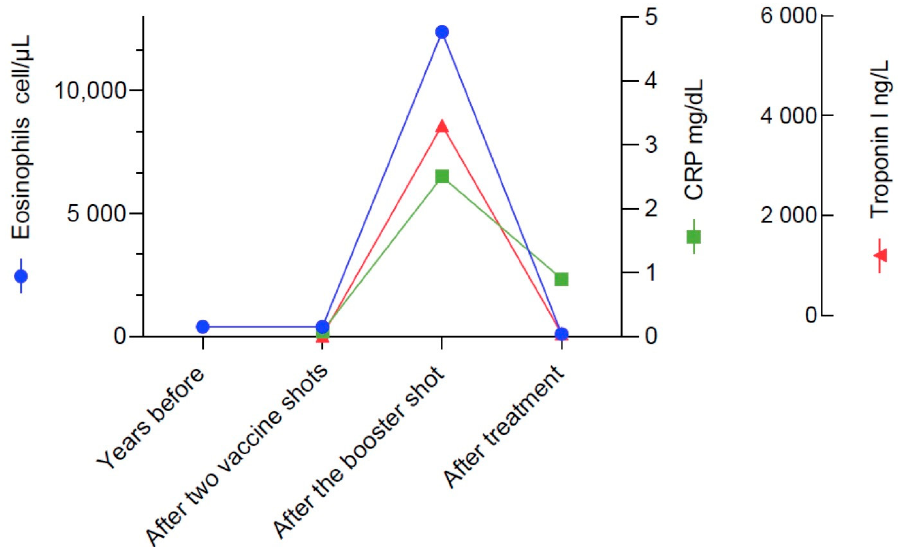
Figure 2. Blood parameters of disease activity in our patient at four timepoints. Notably, blood eosinophils were found to be within the normal range some years previously (in 2018) and also during the worsening of asthma which occurred after the first two vaccine shots and apparently were elevated only once EGPA was manifest.